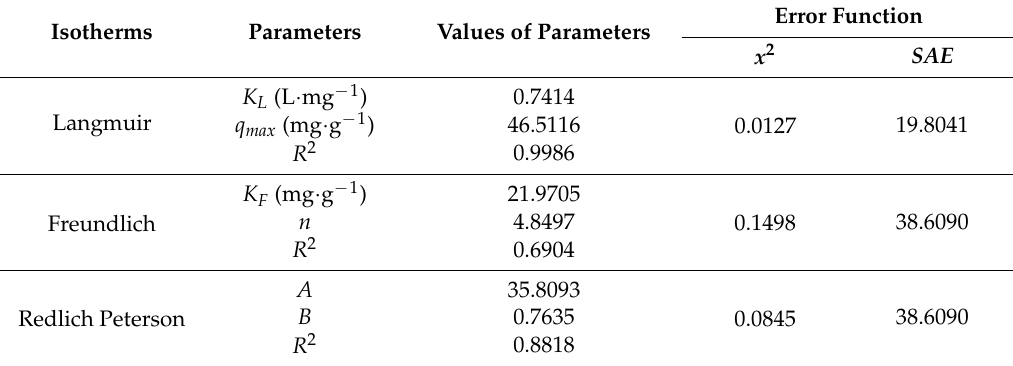
Table 5. Parameters of isotherm models for the adsorption of Se(IV) onto the nZVI/rGO composites.